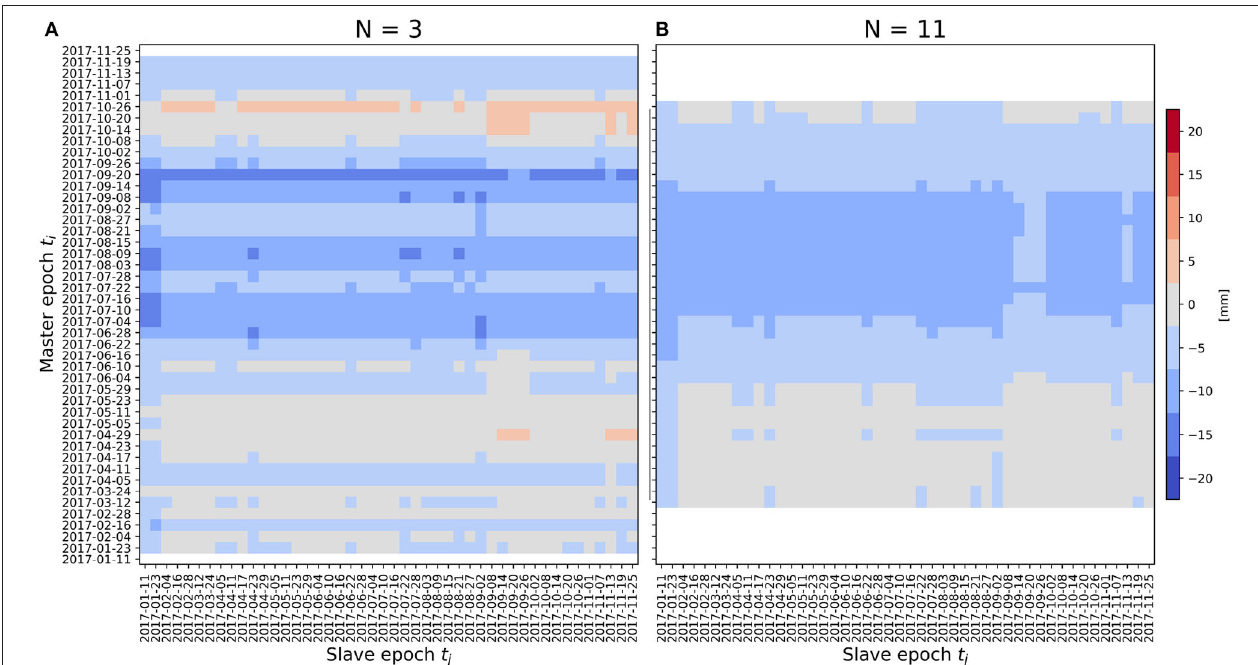
FIGURE 14 | SAR ZTD bias with a N = 3 (A) and N = 11 (B) master epochs µ SAR ZTD s ( t j ; t i | i = 1, ... , N ), as defined in Equation (22), calculated for the entire GACOS data set. A sliding window centered on the t i epochs is